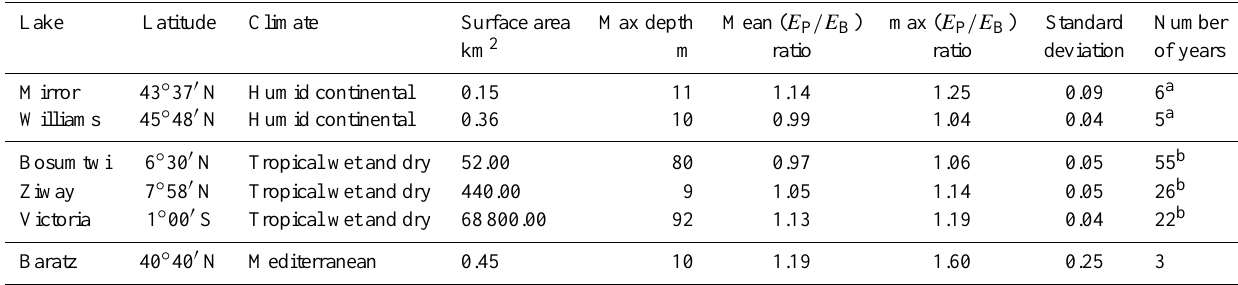
Table 3. Comparison of BREB and Penman’s method for six lakes in three different climatic zones. Climate type is based on Köpper classification. The ratio E P /E B and the SD are calculated using the average monthly evaporation (see Appendix C for details).